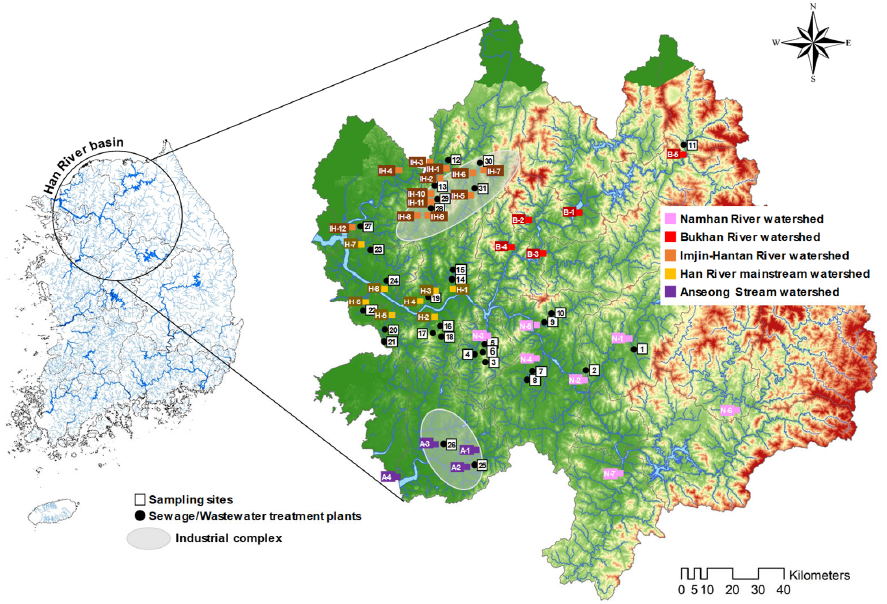
Figure 1. Location of sampling sites along tributaries of the Han River